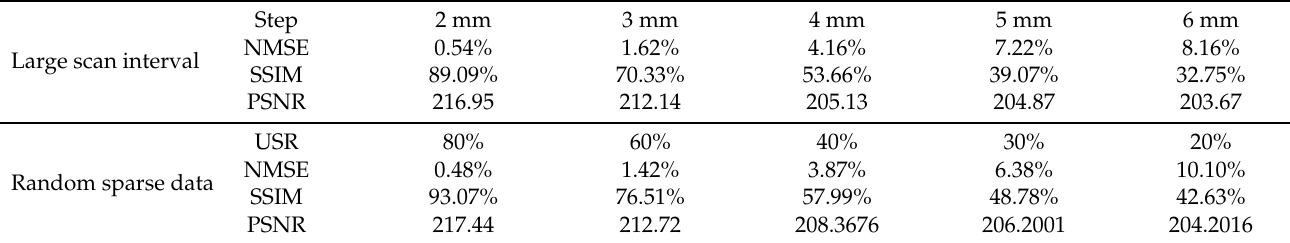
Table 3. NMSE, SSIM, PSNR of reconstructed image in different